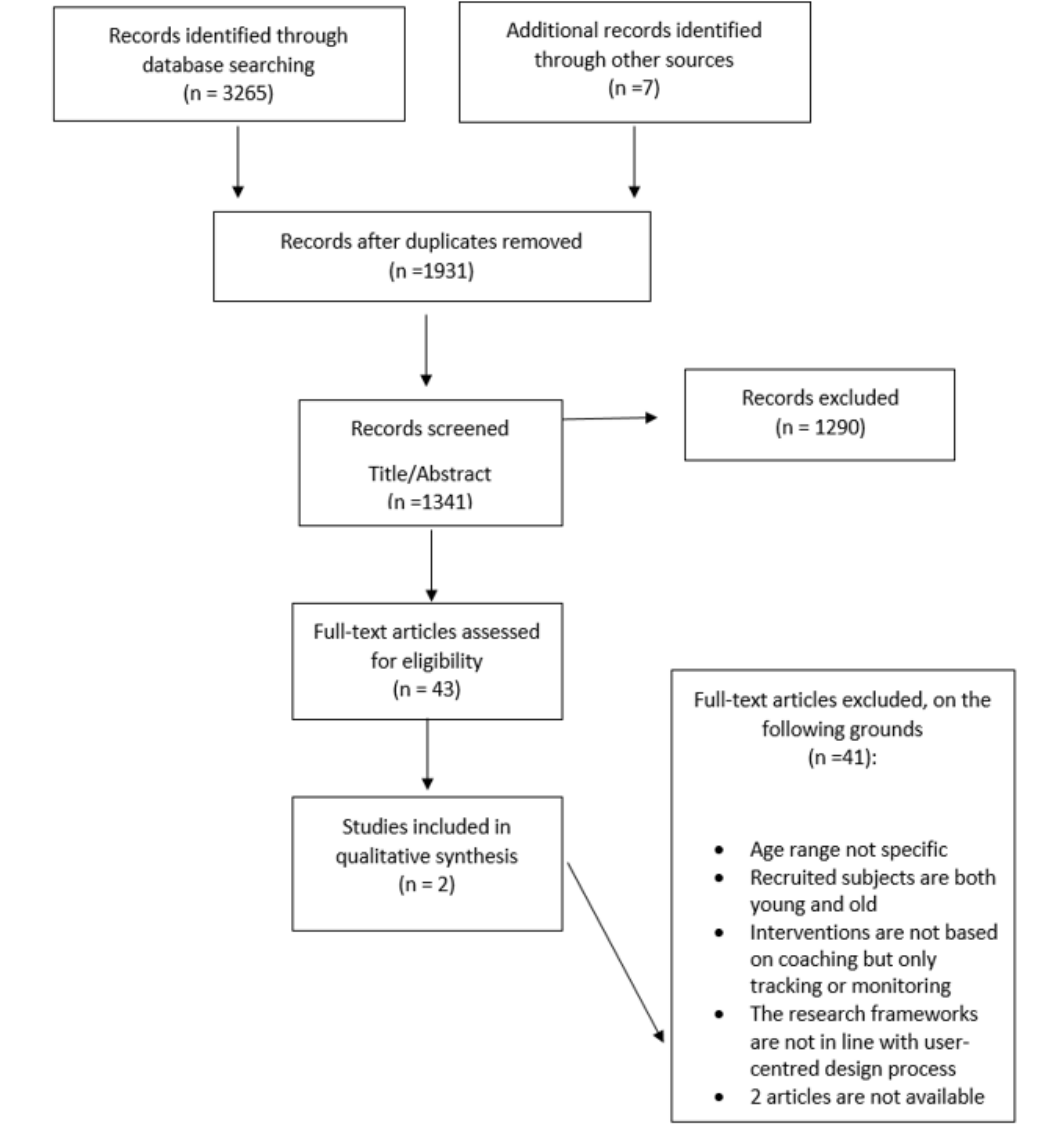
Figure 1. PRISMA flow